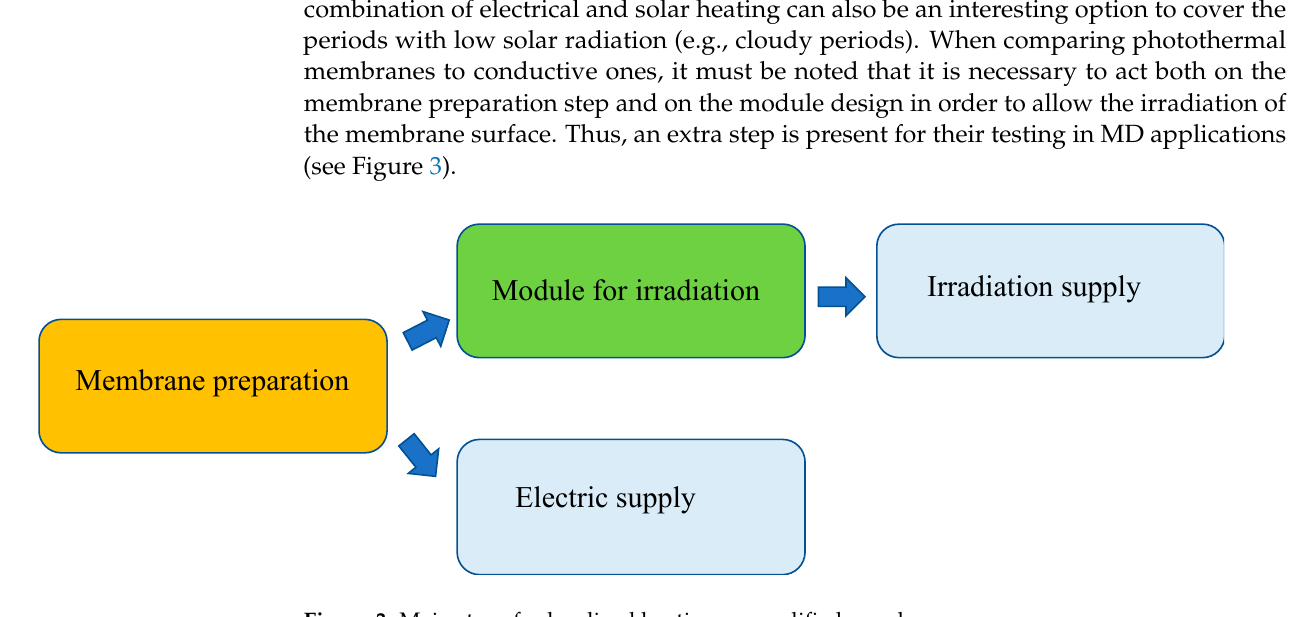
Figure 3. Main steps for localized heating on modified membranes.